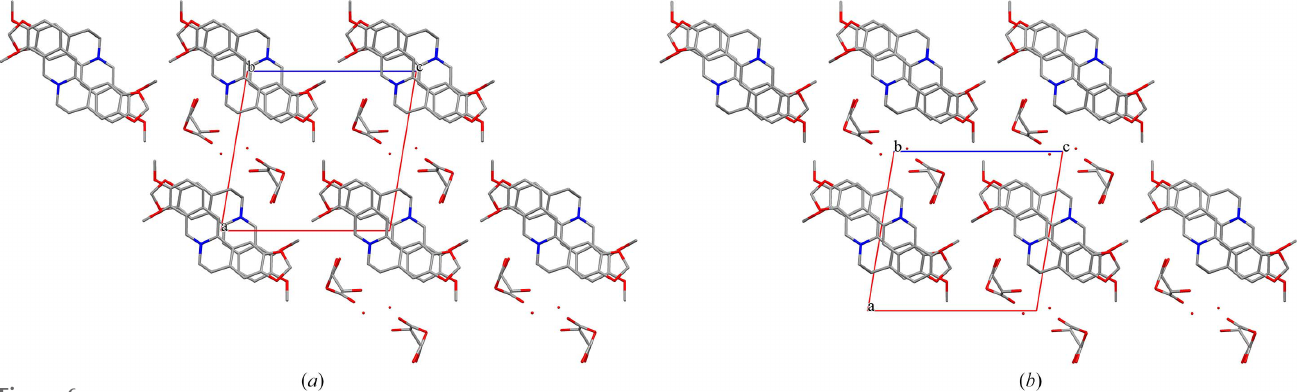
—H (cid:6) (cid:6) (cid:6) O in the TA anion 8 10